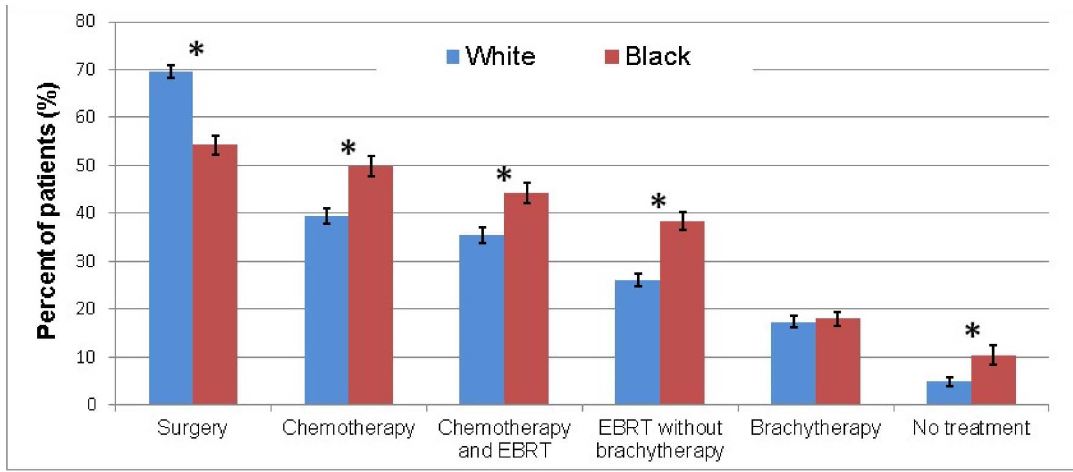
doi:10.1371/journal.pone.0104344.g002